Question: Generate an informative caption for the figure above.
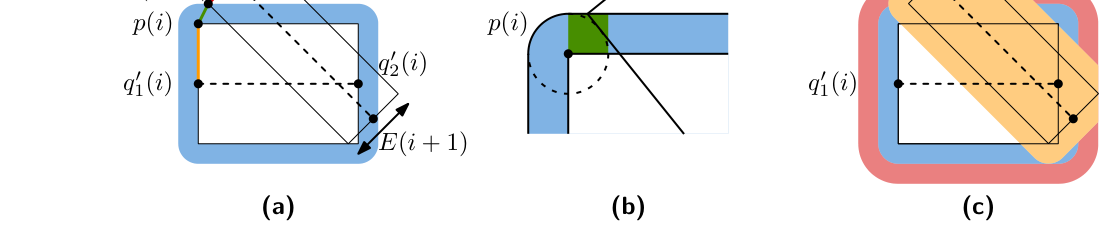
Answer: Constructions for Lemma 23 and 25. (a) All points are inside the (horizontal) bounding box at time i and hence cannot have moved outside the blue border at time i + 1. We bound the length of the three colored line pieces to bound the speed of q1. (b) When a point p on the minor axis of the horizontal box reaches the major axis of the box at i + 1, the minor axis of the same box must touch the green square. (c) At time i + 2 all points cannot have moves outside the width-2 red border around the box at time i, and at most one unit outside the box at time i + 1 (yellow).